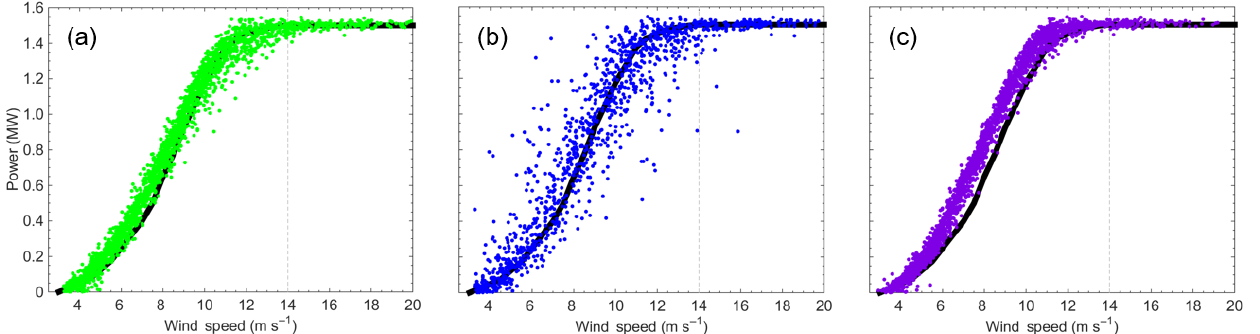
Figure 7. Power curves after filtering for wind speeds between 3.5 and 25ms − 1 , wind directions between 235 and 315 ◦ , and for normal turbine operation: (a) turbine power production vs. 80m cup anemometer wind speed from the met tower, (b) turbine power production vs. 80m wind speed from the lidar, and (c) turbine power production vs. hub-height wind speed from the anemometer on the nacelle. The black line represents an approximation of the manufacturer power curve for the GE 1.5sle (GE Energy, 2009). Wind speed is normalized for density following IEC 61400-12-1 (2015). The grey dashed line marks rated speed.